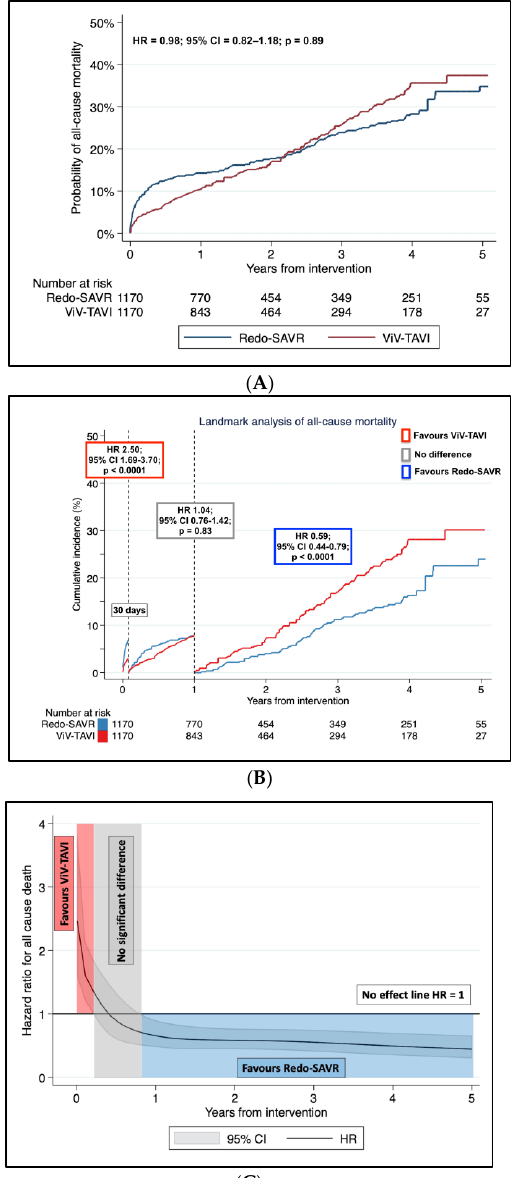
( B ): Landmark analysis of all-cause mortality in Redo-SAVR and ViV-TAVI. Within 30 days from intervention, ViV-TAVI shows a better outcome compared to Redo-SAVR; no difference between the two interventions is reported within 30 days and 12 months; after 12 months, Redo-SAVR shows a better outcome. ( C ): Analysis of the hazard ratio trend over time for all-cause mortality in Redo aortic valve replacement (Redo-SAVR) and valve-in-valve transcatheter aortic valve implantation (ViV- TAVI). The hazard ratio trend was estimated with the fully parametric generalized survival models. The red area shows advantage of ViV-TAVI; the grey area shows no difference between the two interventions; the blue area shows an advantage of Redo-SAVR. The black horizontal line is set at 1 hazard ratio (no effect between the two interventions). HR: hazard ratio; CI: confidence interval.